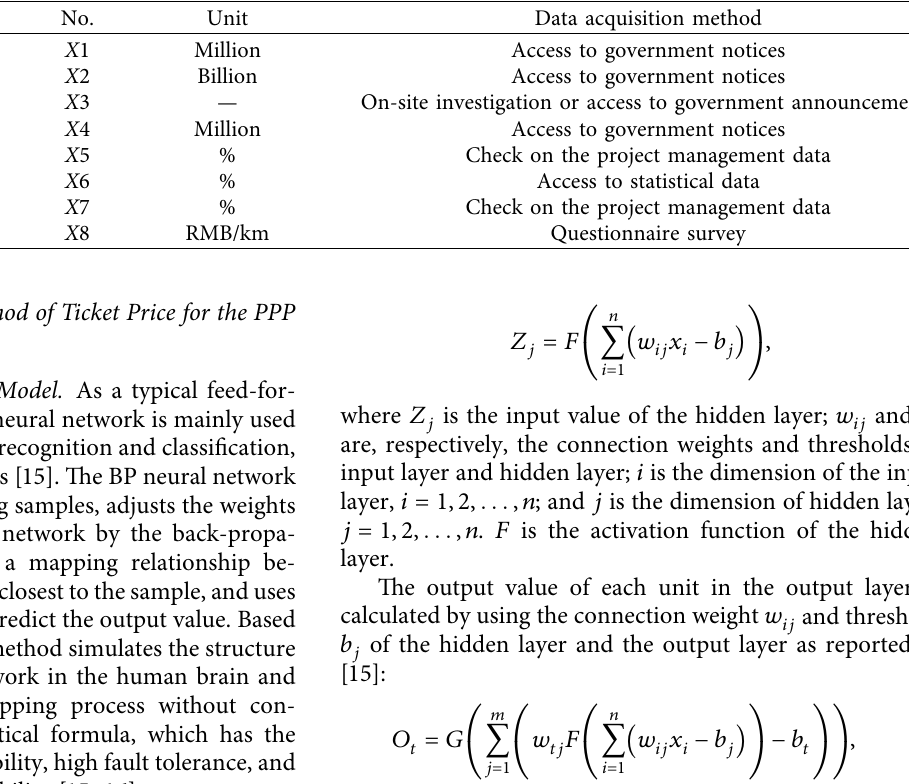
Table 1: Input variables for the prediction of the ticket for the PPP subway